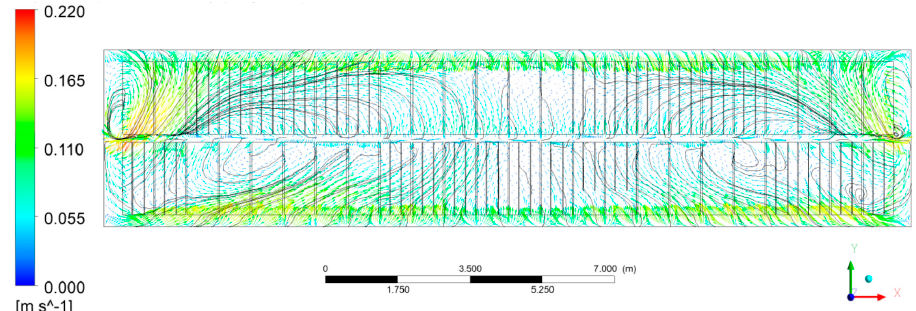
11 of 17 Figure 7. Average alumina concentration in a over and underfeeding cycle (measured data). 3.2. Effect of Slots The slotted anode technology is the most exciting method that can be applied in industrial scale. Most researchers focused their attention on gas coverage [26,27], bubble-induced resistance [28], and bath flow [16], with very little literature reporting the alumina mixing in a slotted anode cell. 3.2.1. Bath Flow